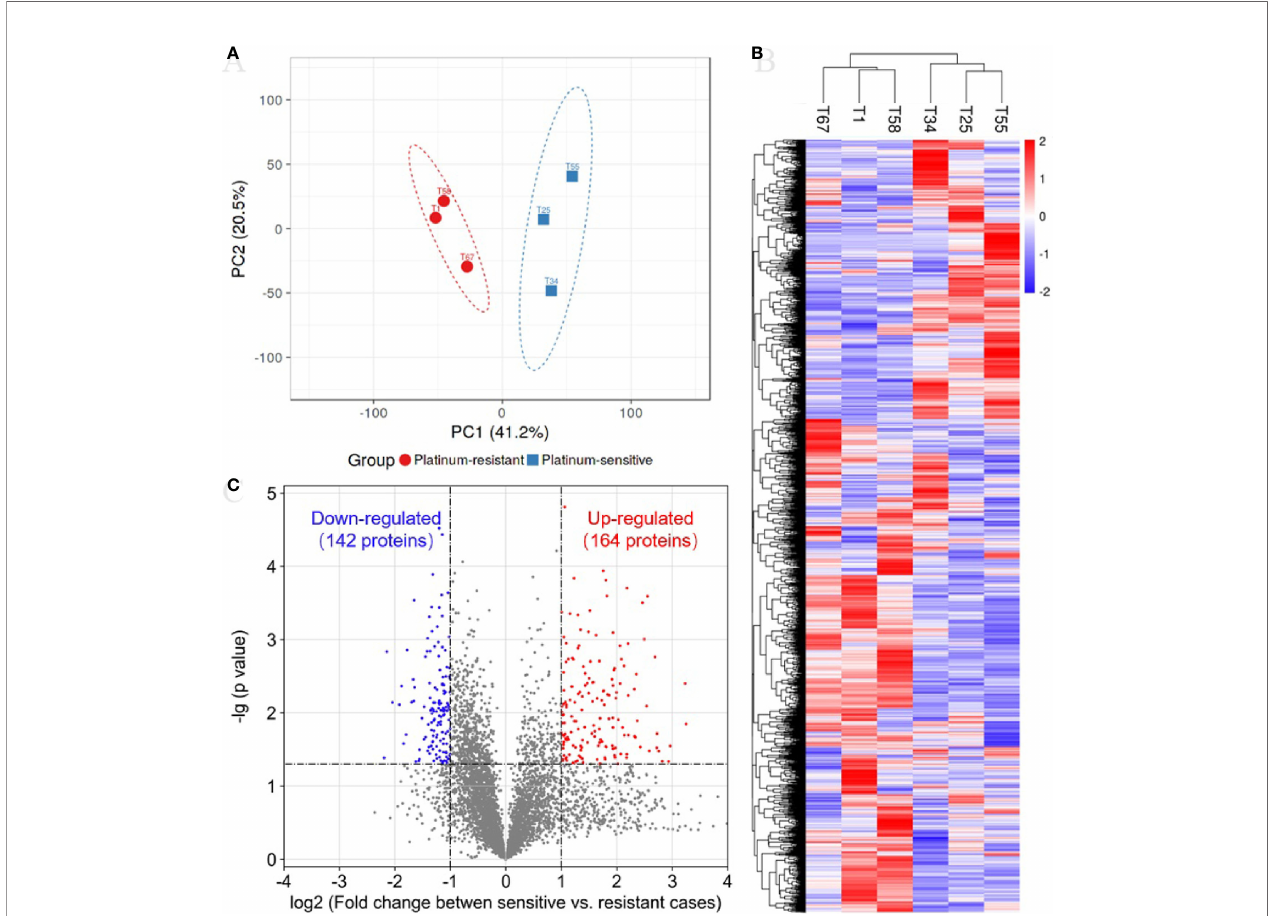
FIGURE 1 | Proteomic analysis reveals a difference protein expression pro fi ling between platinum-sensitive and platinum-resistant tumors. (A) Visualization of the fi rst two principal components (PCs) from principal component analysis (PCA) separating samples based on the Z-score normalized quanti fi cation for identi fi ed proteins. The tissues from platinum-sensitive (blue square) and platinum-resistant (red circle) patients are labelled with different shapes and colors, and a 95% con fi dence ellipse for each group of samples was drawn. (B) Hierarchical clustering and heatmap of Z-score normalized expression values of all identi fi ed proteins in platinum-sensitive and platinum-resistant tumors. Red, high abundance; and blue, low abundance. (C) Volcano plot for the comparison between the platinum-sensitive and platinum- resistant tumors. The cutoff values of fold change ≥ 2 and p -value < 0.05 were utilized to identify differentially expressed proteins. Non-changed proteins are shown as gray dots, upregulated proteins as red dots, and downregulated proteins as blue